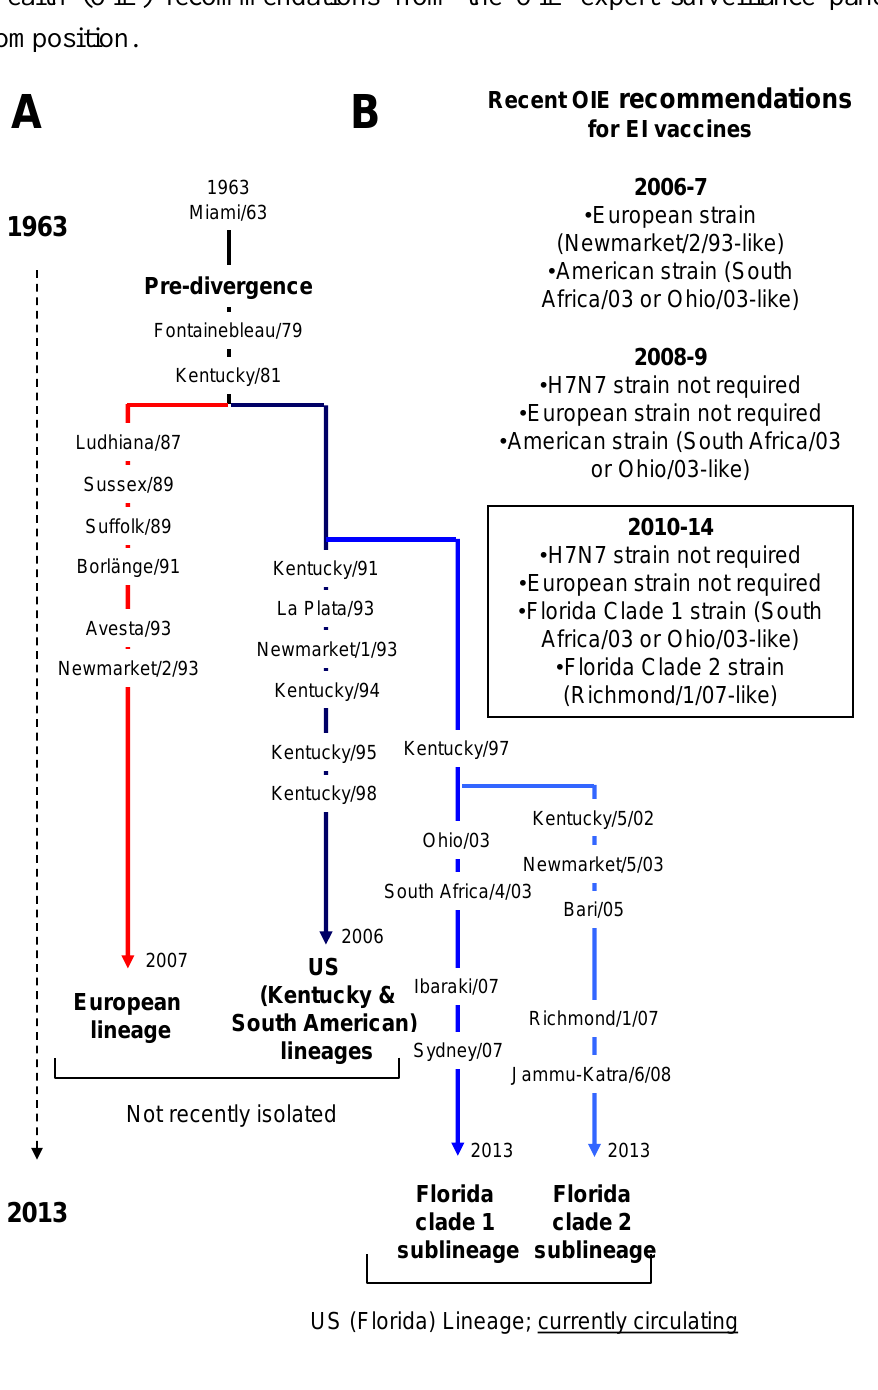
Figure 1. ( A ) Schematic of equine influenza virus (EIV) evolution. All main